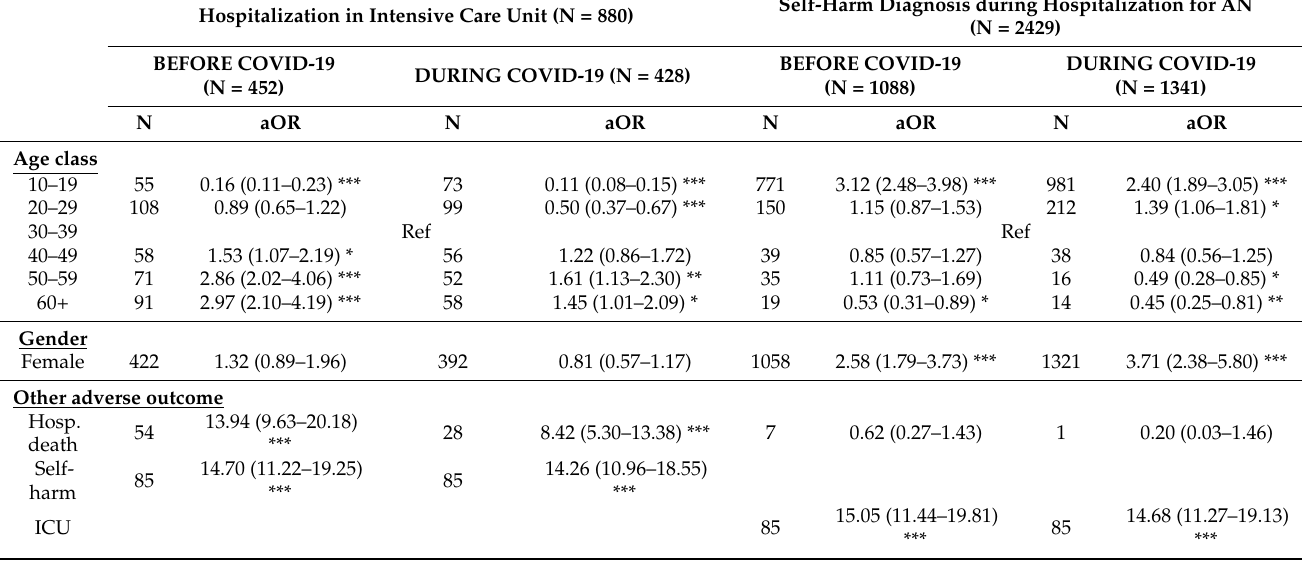
Table 2. Risk of admission to an intensive care unit or self-harm diagnosis associated with hospital- ization for AN (adjusted odds ratios before and after beginning of the COVID-19 pandemic). Self-Harm Diagnosis during Hospitalization for AN Hospitalization in Intensive Care Unit (N = 880) (N = 2429) DURING COVID-19 (N =